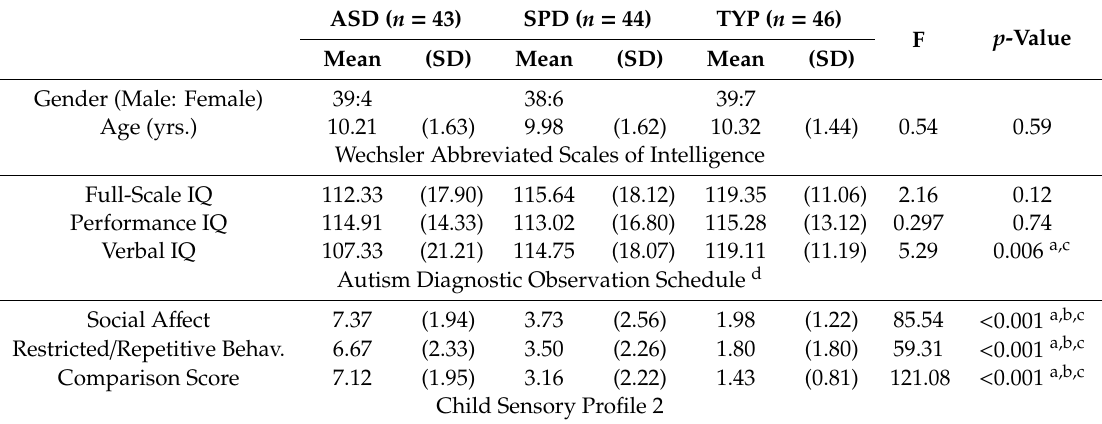
Table 1. Participant characteristics .